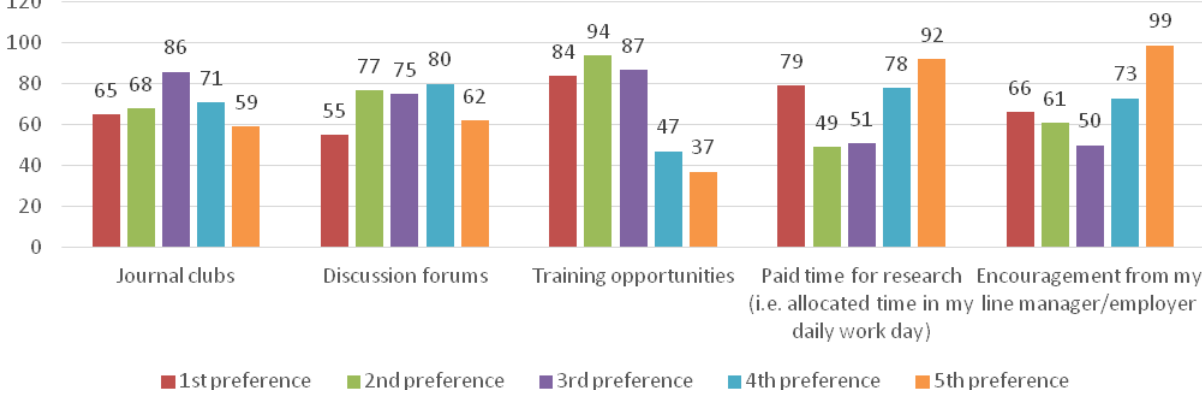
Figure 1 : Distribution of responses to the question of methods to increase the adoption of